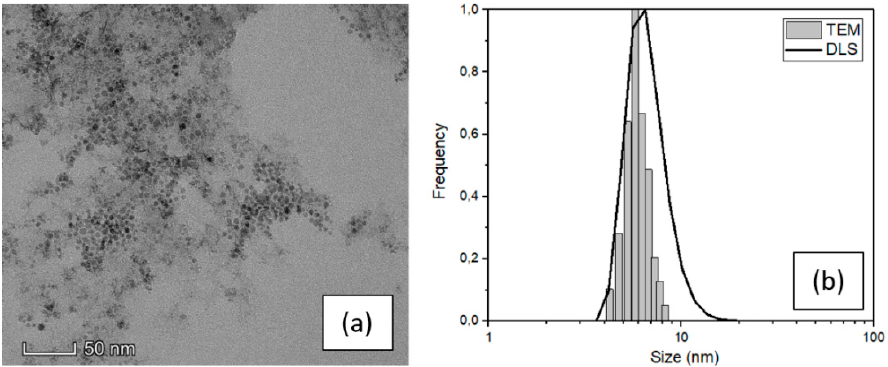
Figure 1. ( a ) TEM image and ( b ) size distribution of SPIONs dispersed in water obtained by TEM and DLS. and